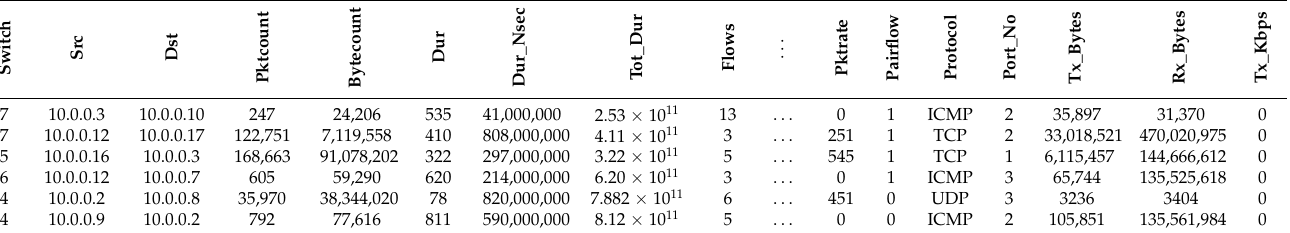
Table 8. Input parameters for network traffic implementation of an emulated test of the BDLSTM- autoencoder model’s ability to detect DDoS